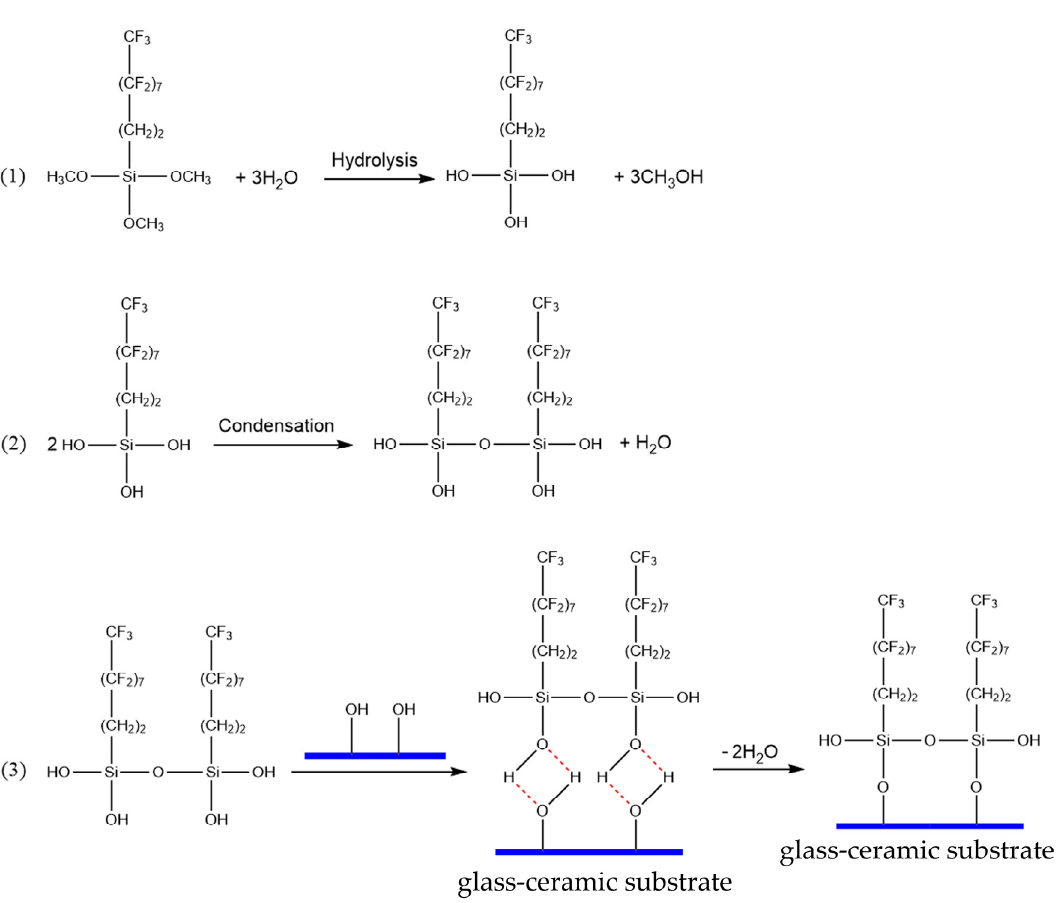
Figure 9. The reaction process between FAS-17 and glass-ceramic.